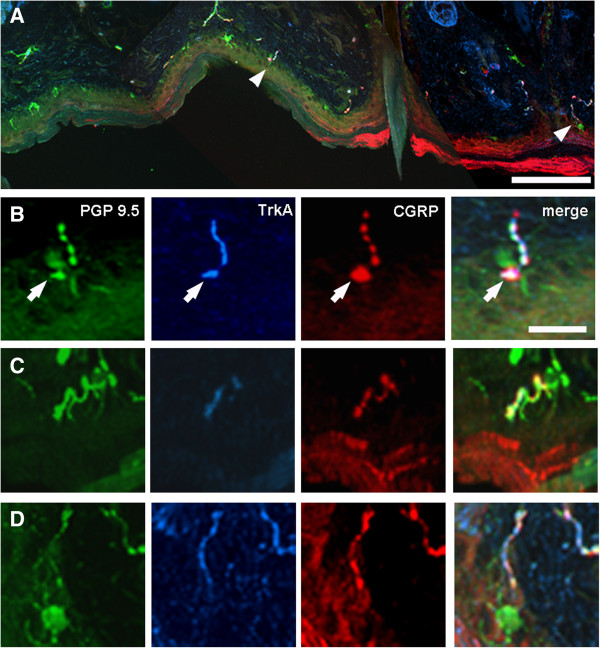
Examples of intra-epidermal nerve fibres (IENFs) 21 days after chronic constriction injury of the mental nerve. The low-power image (A) shows a strip of partially-denervated skin that contains two IENFs (arrowheads), which are shown at higher magnification in B and D. Each of the fibres shown at high magnification in B – D is double-labelled for both TrkA (Tropomyosin-related kinase A, blue) and the neuropeptide Calcitonin gene-related peptide (CGRP, red). In B a Merkel disc (arrow) within the epidermis is also CGRP-labelled and a Langerhans cell is labelled with protein gene-product 9.5 (PGP 9.5, green) in D. Scale bar = 200 μm (A) and 10 μm (B; also applies to C, D).